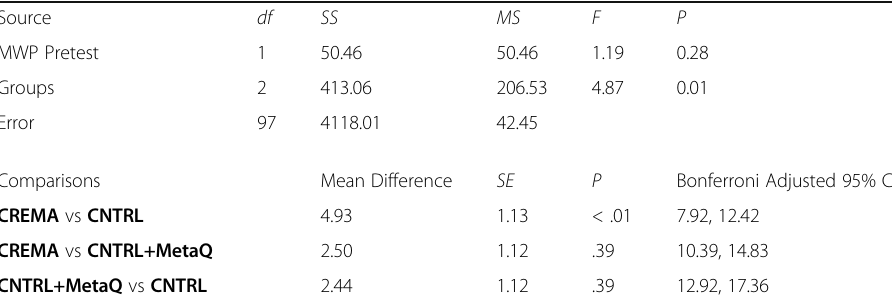
Table 9 ANCOVA results, multiple comparisons, and mean differences in MWP posttest for MWP pretest Source